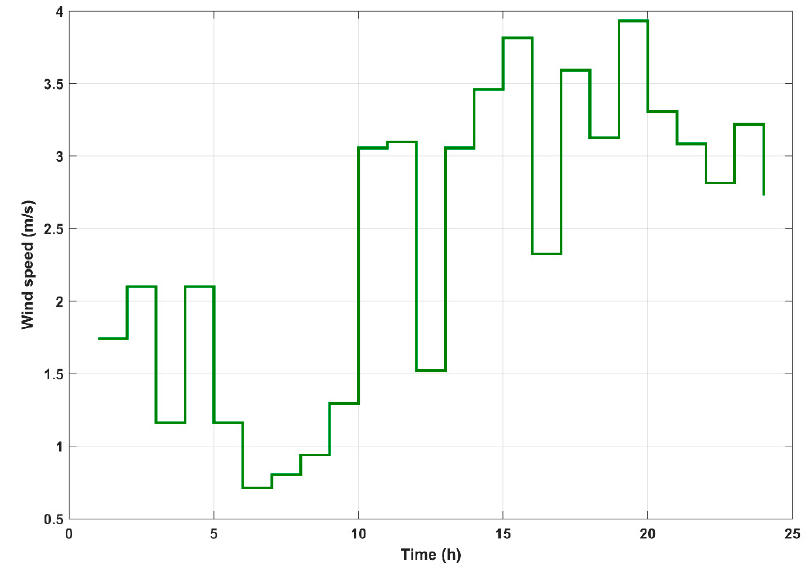
Figure 3. Solar radiation flux (irradiance) and ambient temperature data for the case studies.